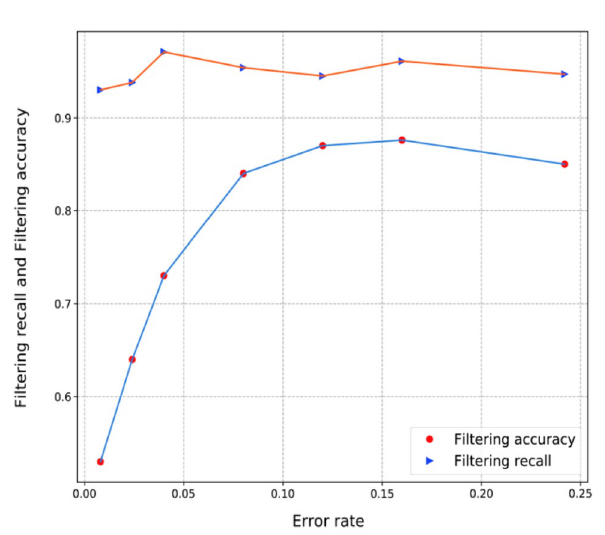
Figure 4. The data set contains the relationship between the ratio of the noise image of the tag within the class and the screening